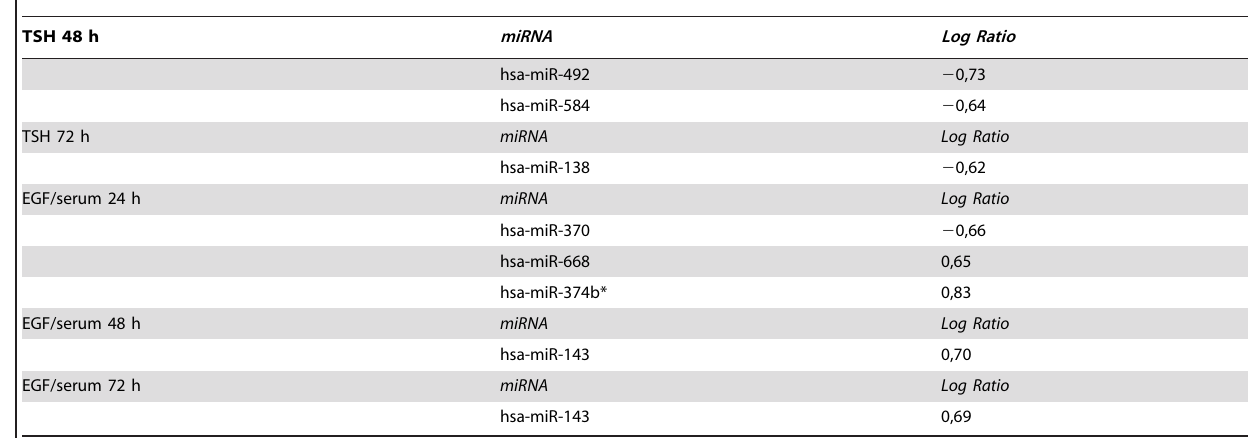
Table 1. miRNA regulated in primary culture